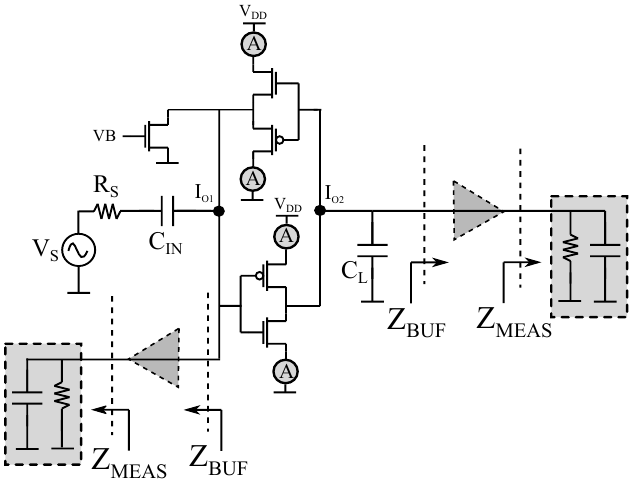
Figure 17. Measurement Set-up. Z MEAS is the input impedance of oscilloscope or voltmeter, Z BUF is the input impedance of the buffer used to reduce the load effect of the measurement